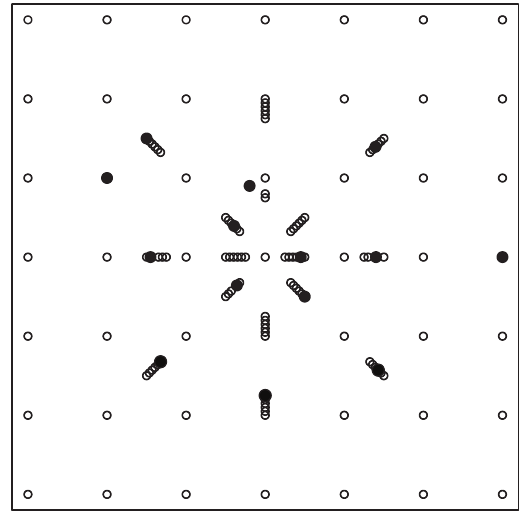
Figure 1. Sampling grid with 141 points to assess FCO 2 , temperature, soil moisture and physico- chemical soil properties. (•) Points used in the procedure for external